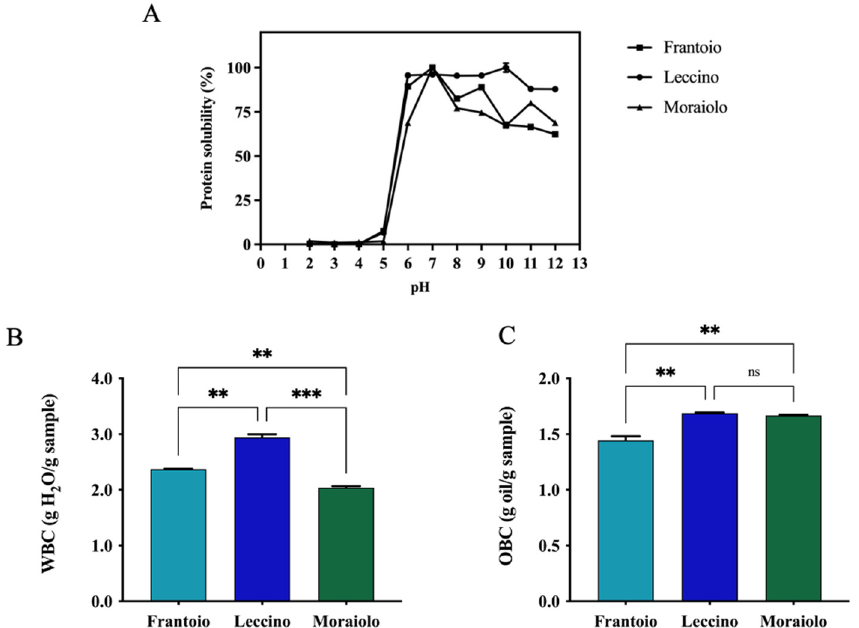
Figure 3. ( A ) Protein solubility. ( B ) Water-binding capacity (WBC). ( C ) Oil-binding capacity (OBC). Statistical analysis was performed by one-way ANOVA followed by Tukey’s pos-hoc test. (***) p < 0.001, (**) p < 0.01; ns, not significant. The data are represented as the means ± s.d. of three inde- independent